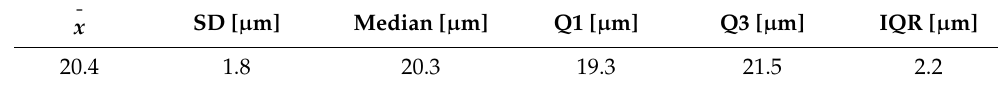
¯ x —mean, SD—standard